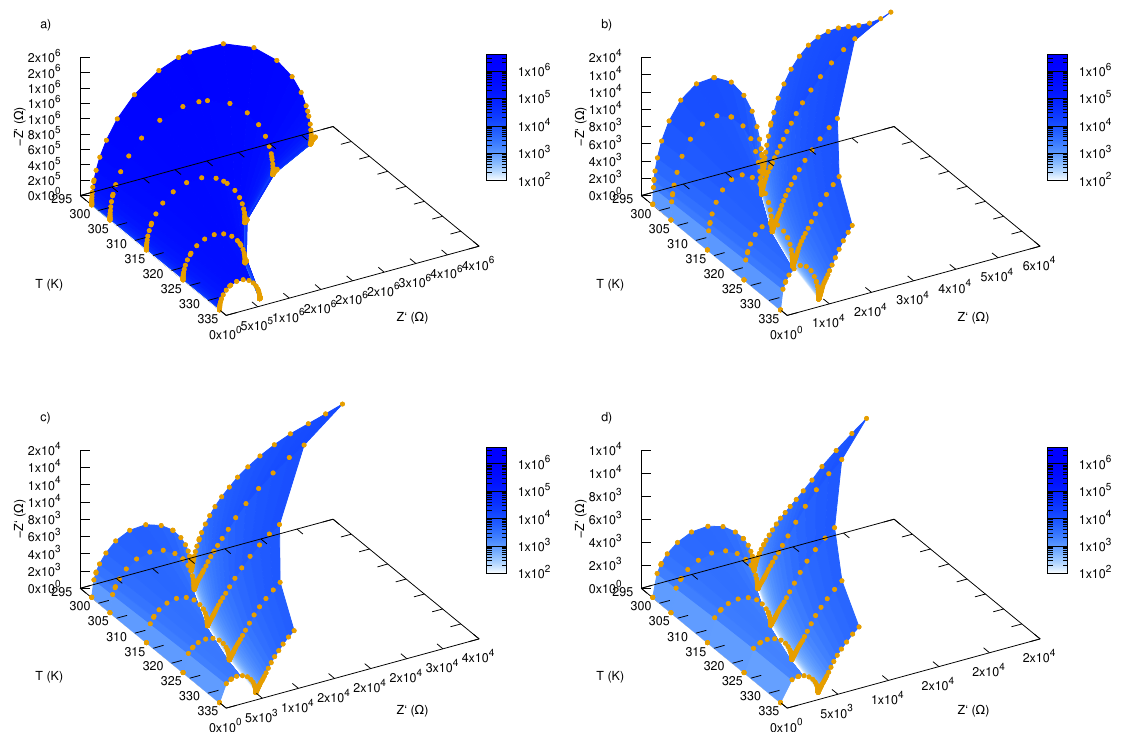
Figure 9. Nyquist plots of silicon oxide lignin ethylene glycol nanofluids as function of frequency and temperature for ( a ) pure ethylene glycol, ( b ) 0.01 mass fraction, ( c ) 0.02 mass fraction, ( d ) 0.03 mass